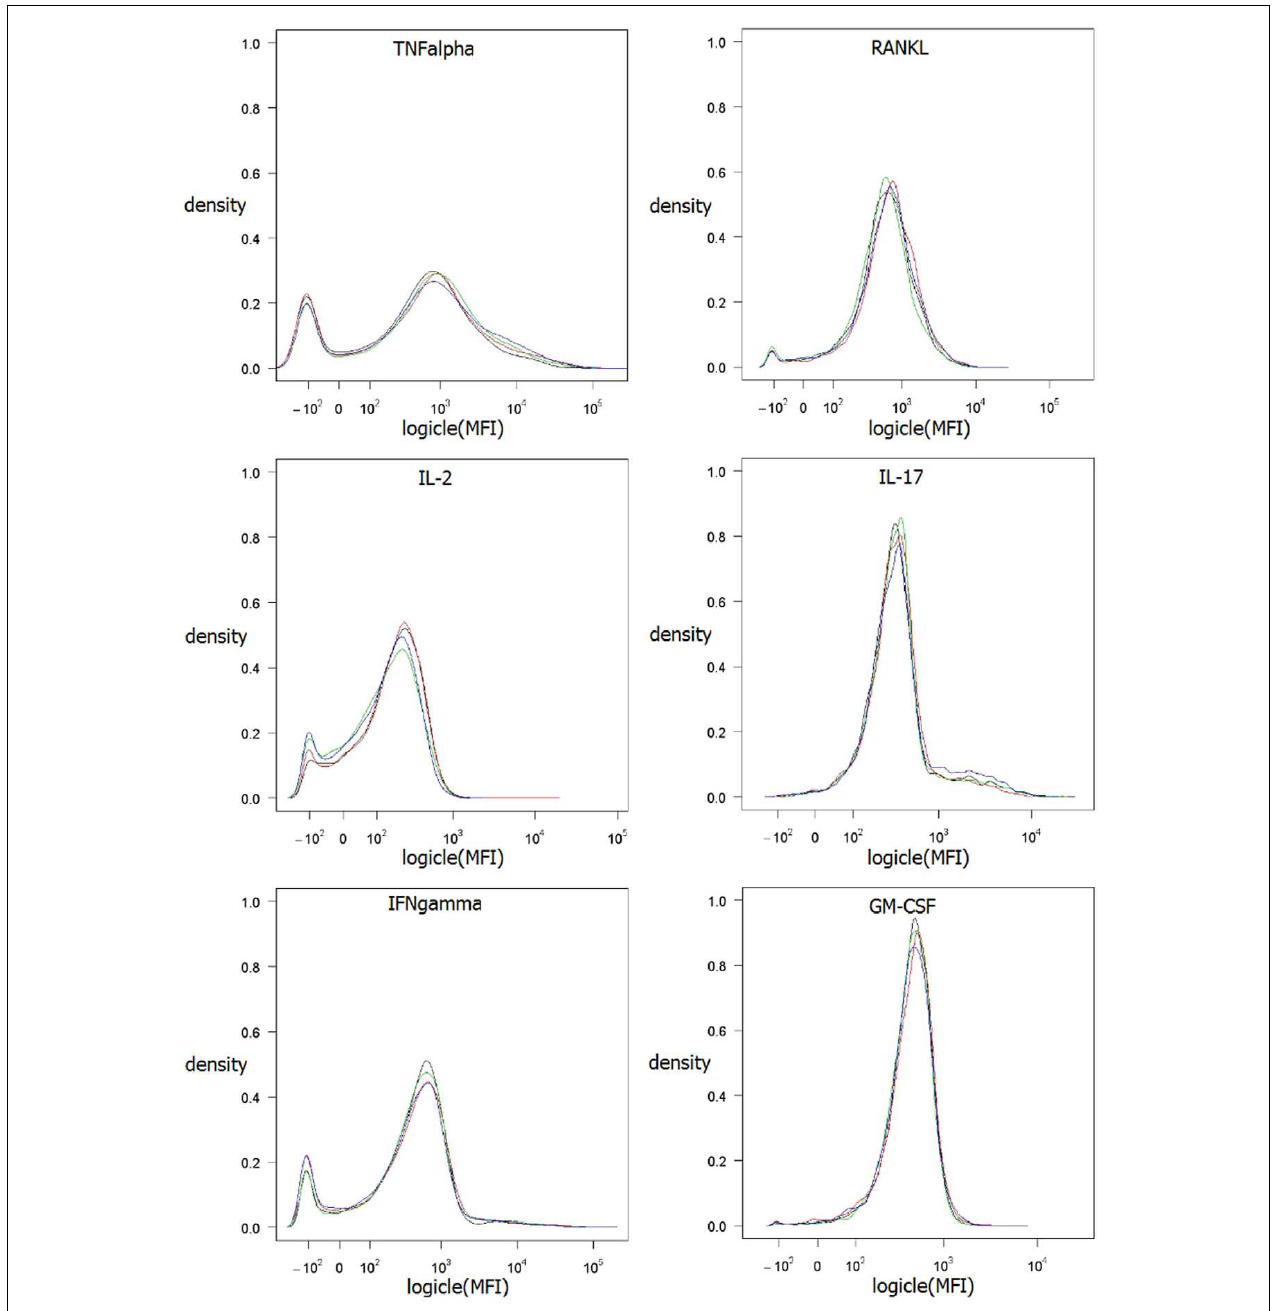
FIGURE 2 | Kernel density estimation of MFI values of the four biological replicates. Method density from R (R Development CoreTeam, 2009) was